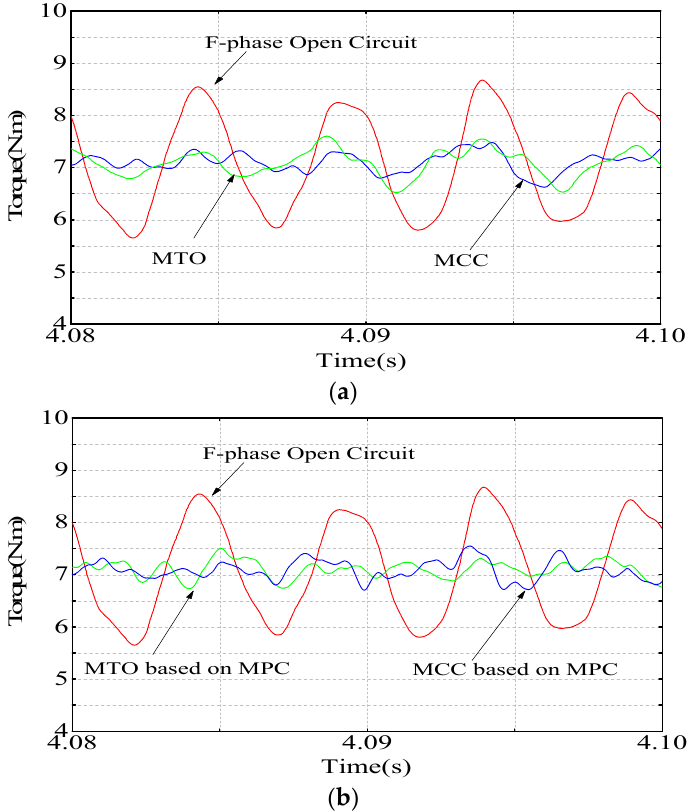
Figure 10. Torque in fault operation and fault-tolerant operation. ( a ) Fault-tolerant control with traditional MCC and MTO. ( b ) Fault-tolerant control with proposed MCC and MTO.